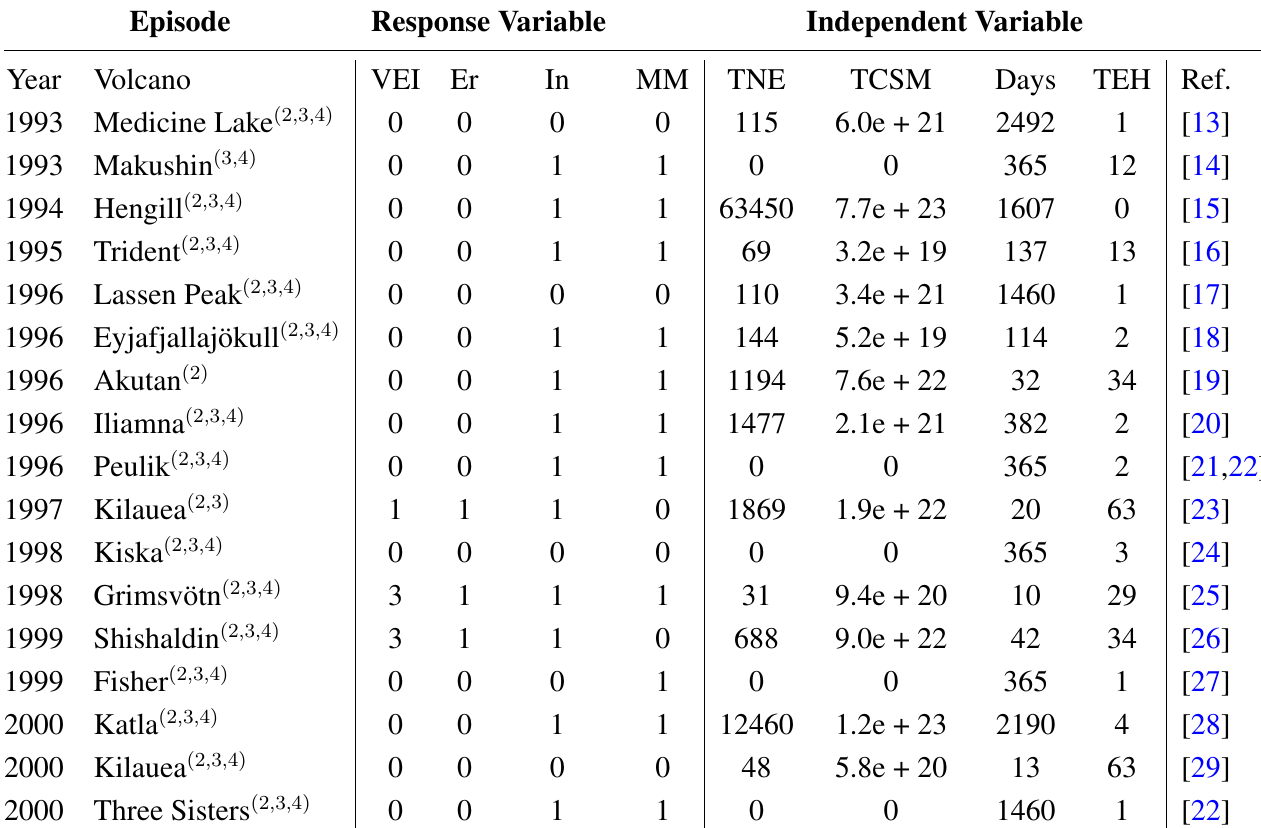
Table 1. Raw logistic regression training